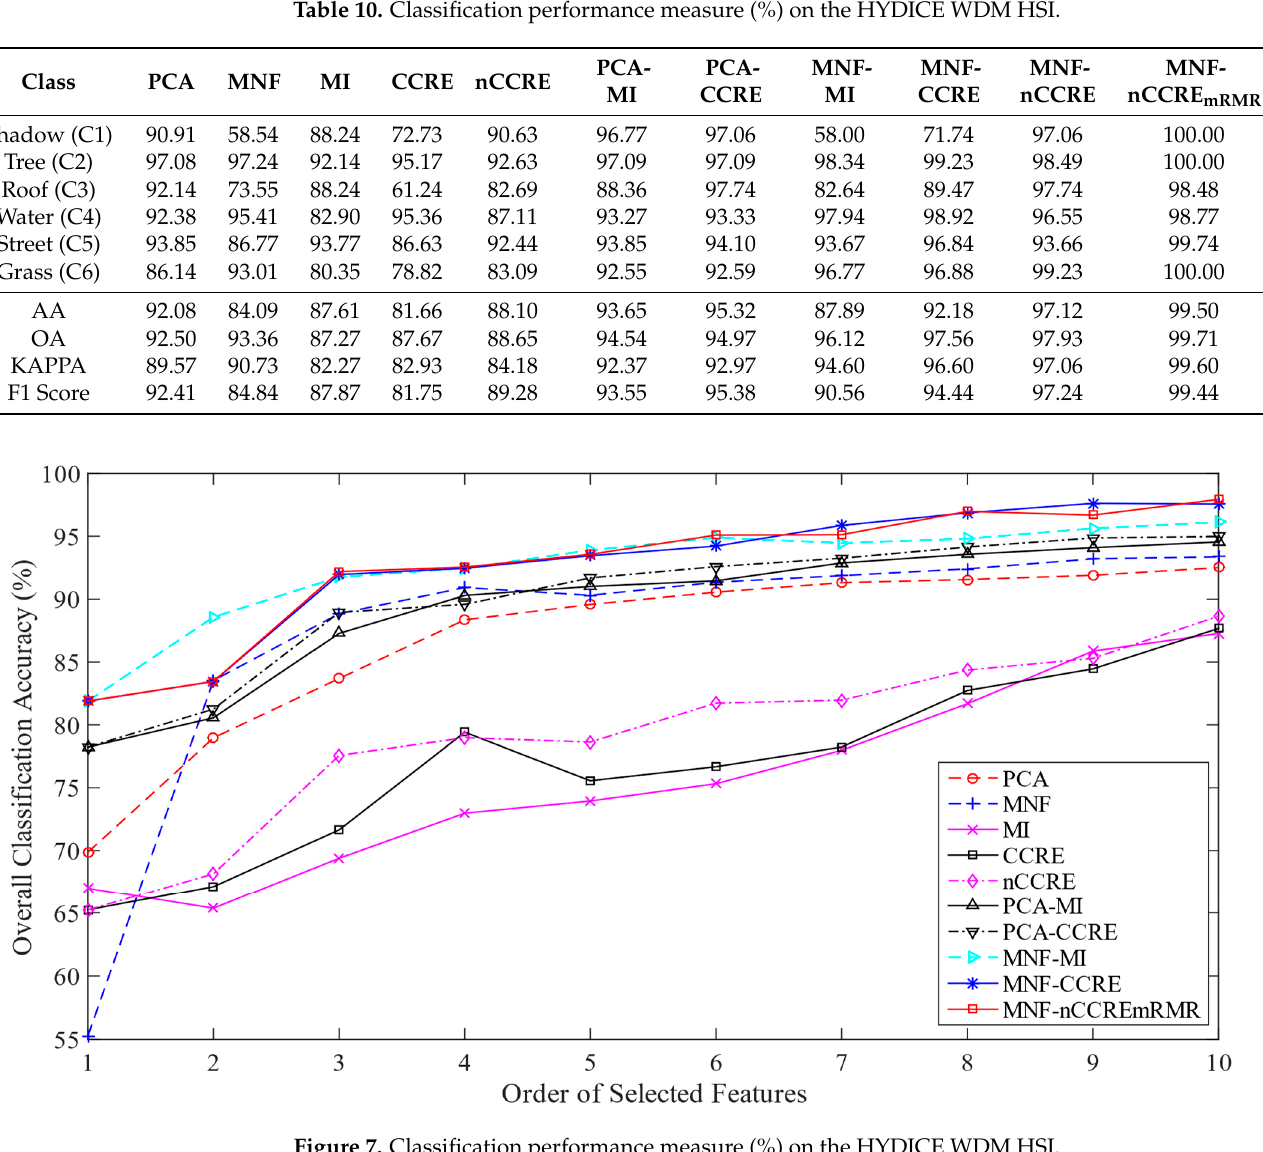
Figure 7. Classification performance measure (%) on the HYDICE WDM HSI.